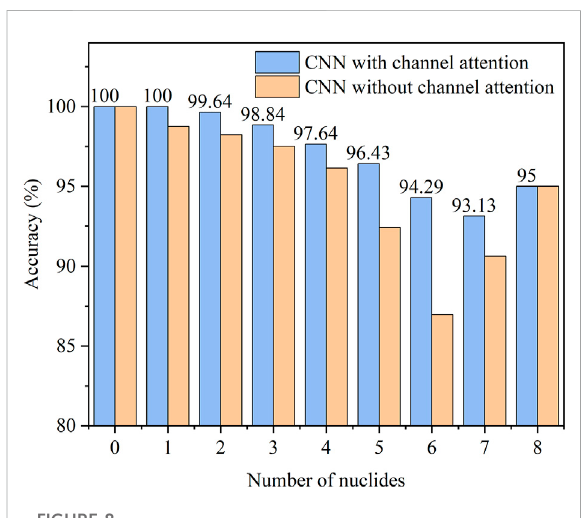
FIGURE 8 Identi fi cation accuracy of the spectra with different numbers of nuclides in the test